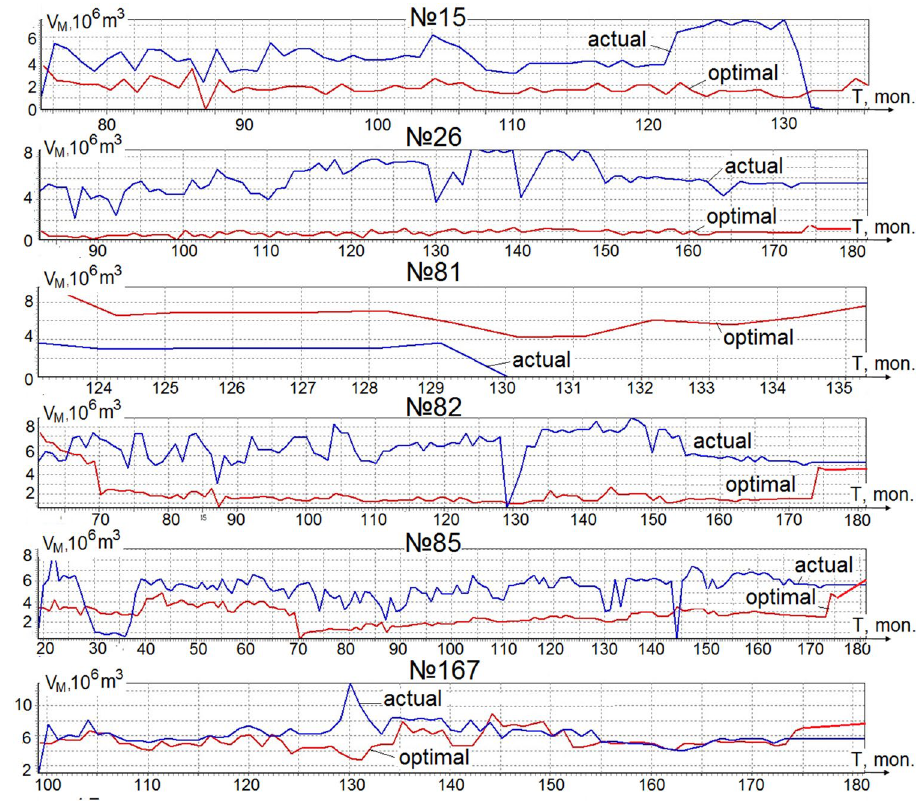
Fig. 8 Monthly gas production for development wells No. 15, No. 26, No. 81, No. 82, No. 85, and No. 167 for «actual» and optimal alternatives of reservoir